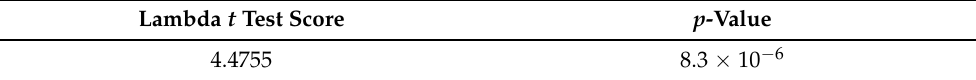
Table 3. Results of the test for over-dispersion verification.